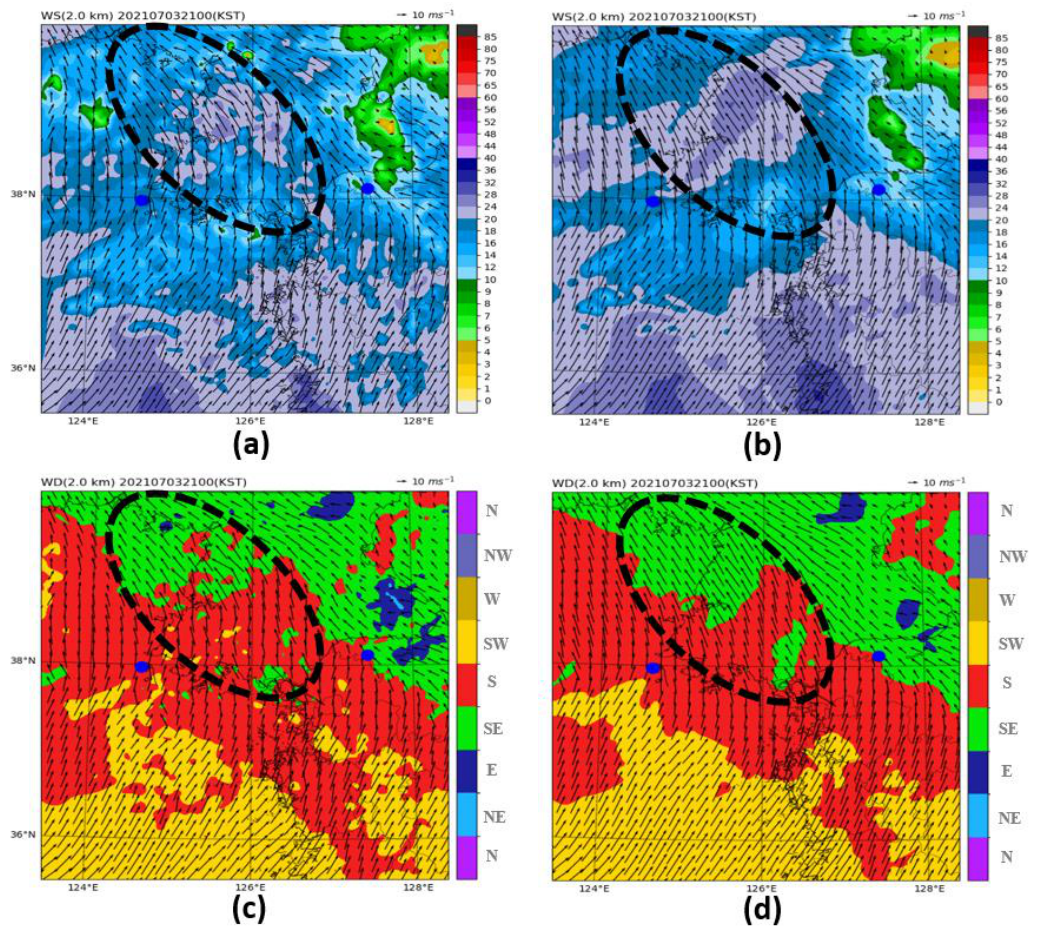
Figure 13. Comparison of (top) wind speed and (bottom) wind direction at an altitude of 2 km derived from WISSDOM at 2100 LST on 3 July 2021; ( a , c ) using raw radial velocity and ( b , d ) using quality-controlled radial velocity.